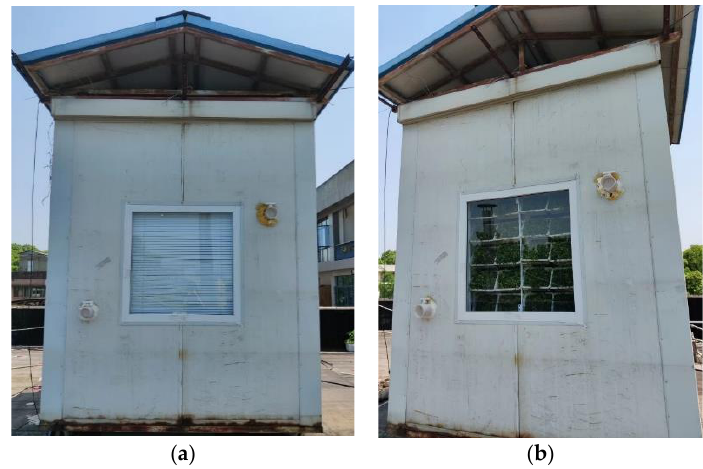
Figure 4. Experimental room: ( a ) Window with louver; ( b ) window with MVGSD.